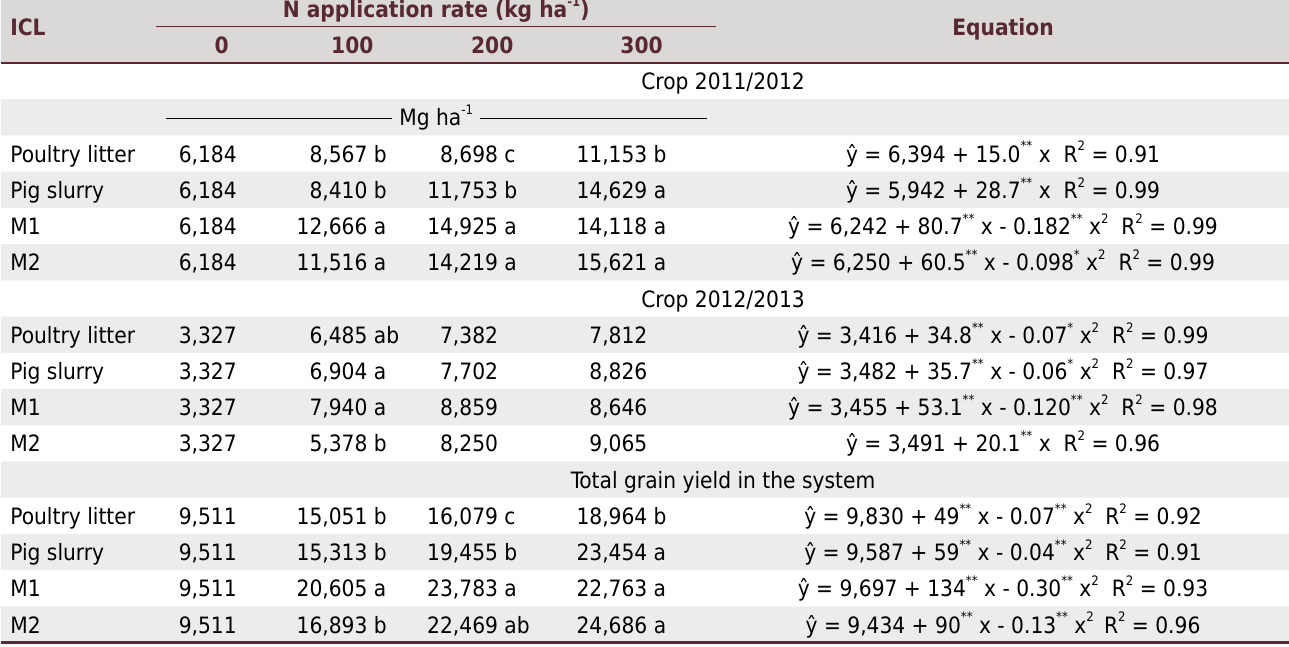
Table 7. Maize yield according to application rates of nitrogen with organic and mineral fertilizers in integrated crop-livestock systems in 2011/2012 and 2012/2013 harvests